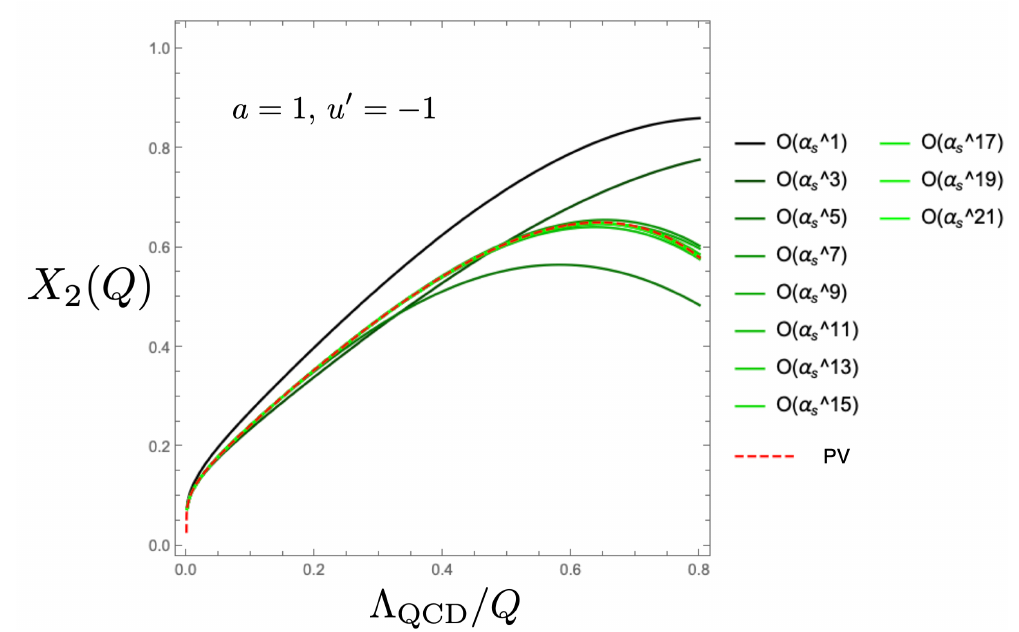
Figure 6 . Comparison of the PV prescription (dashed red line) and the FTRS method for X 2 ( Q ) (green lines with gradation). We set b 0 = 1 . In the momentum space, we truncate the series at O ( α k +1 ) for k = 1 , · · · , 21 s